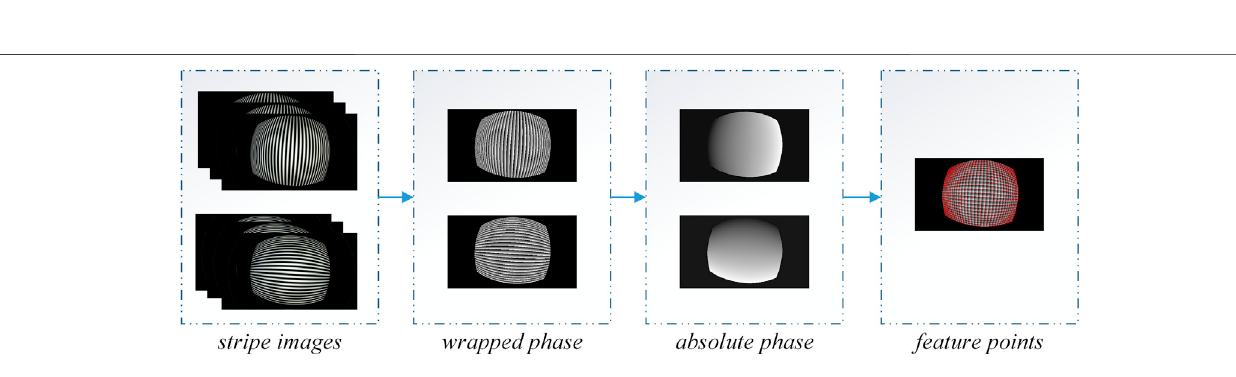
FIGURE 3 | The training process. (A) The effect of loss functions on the neural-network; (B) The effect of optimizers on the neural-network.